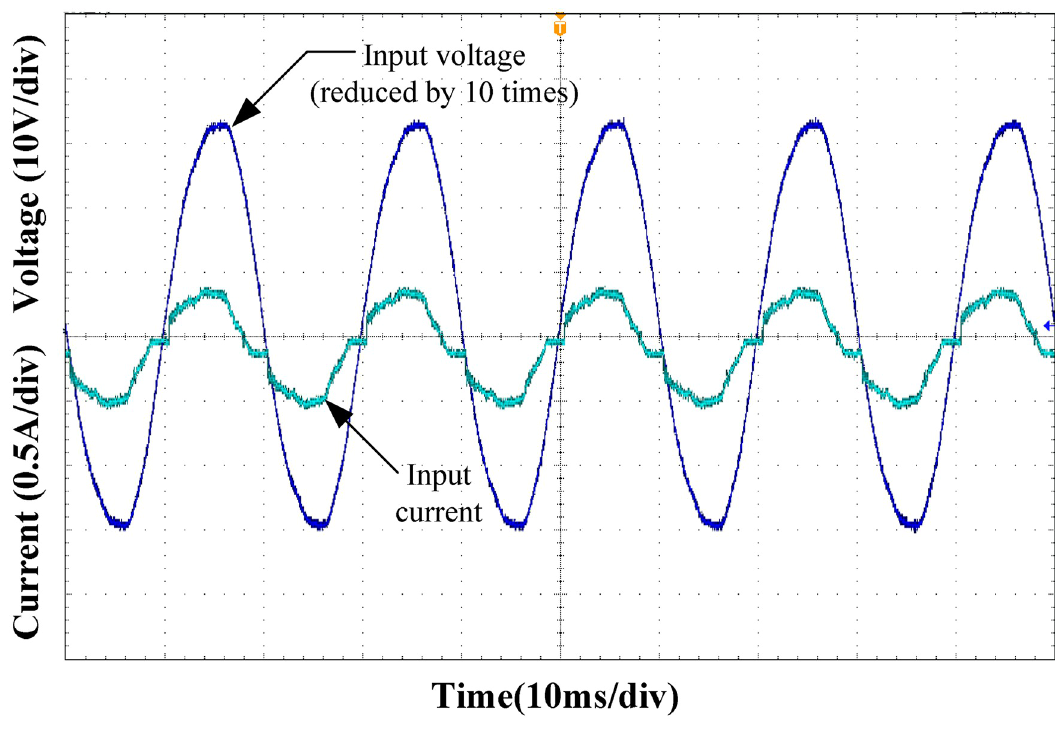
Fig 16. Input voltage and current at 50% load.